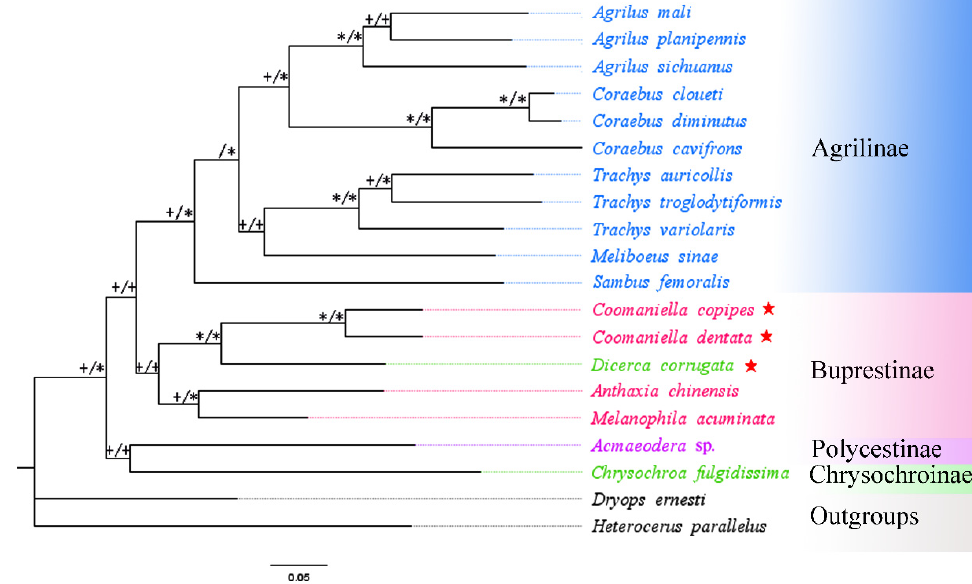
Figure 9. Phylogenetic relationships of 18 selected buprestid species inferred based on maximum-likelihood and Bayesian analyses of two rRNA genes. * ML bootstrap = 100 or posterior probabilities = 1; + ML bootstrap ≥ 50 or posterior probabilities ≥ 0.5; Red star: means species which are newly sequenced in this study.